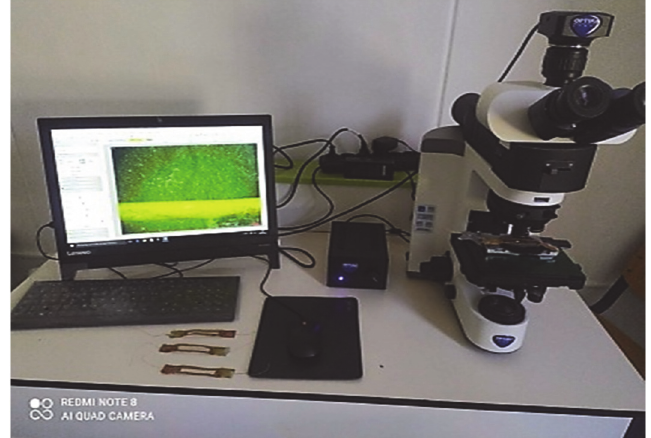
Figure 5: Optical microscope imaging used for measurement palm date fibers diameter.